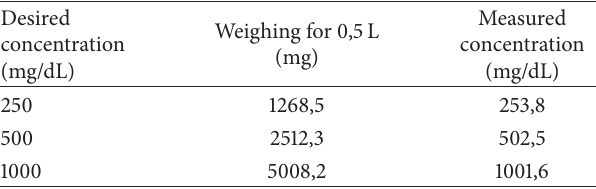
Figure 2: Simplified technical drawing of the container (top view). Lucite (upper and side walls) and PTFE (lower wall). Container height is 3 cm. Table 1: Weighing of D-glucose for sample preparation of physio- logical saline-glucose solutions.